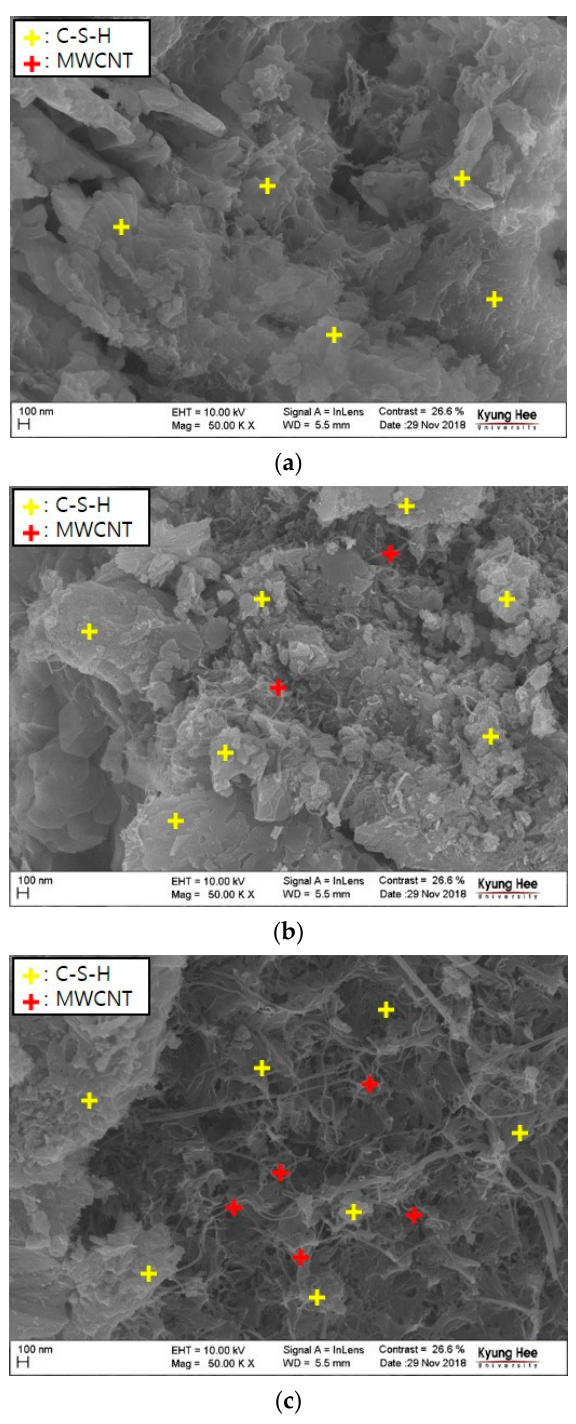
Figure 11. FE-SEM images of the ( a ) OPC, ( b ) MW-0.1, and ( c ) MW-1.0 specimens.